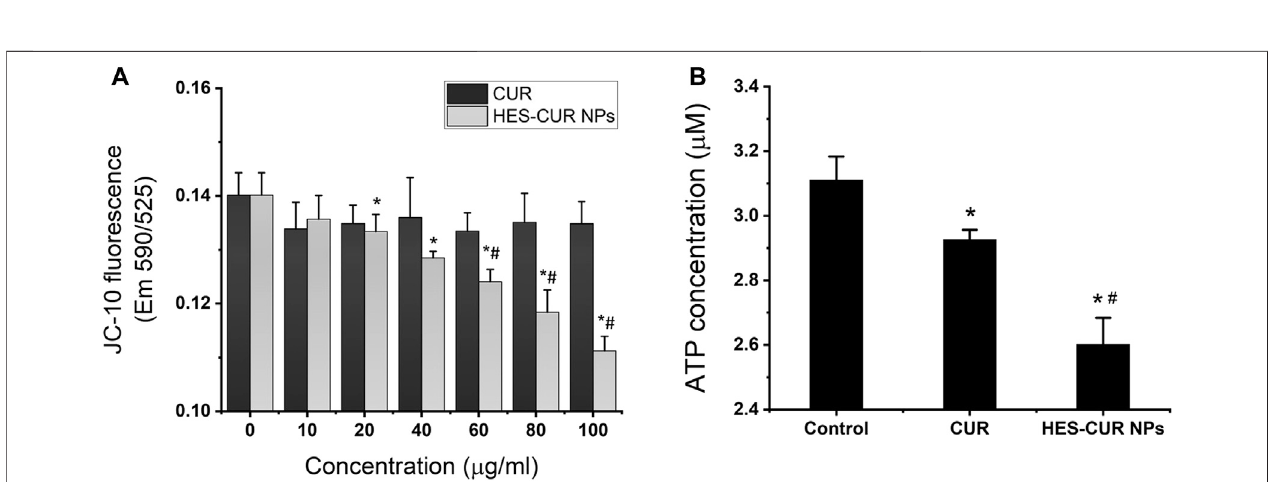
FIGURE 7 | Effects of CUR and HES-CUR NPs on (A) MMP and (B) ATP levels. Data were expressed as mean ± SD, and the experiments were repeated thrice. * p < 0.05, compared to 0 ug/ml HES-CUR NPs; # p < 0.05, compared to the corresponding samples treated by CUR.